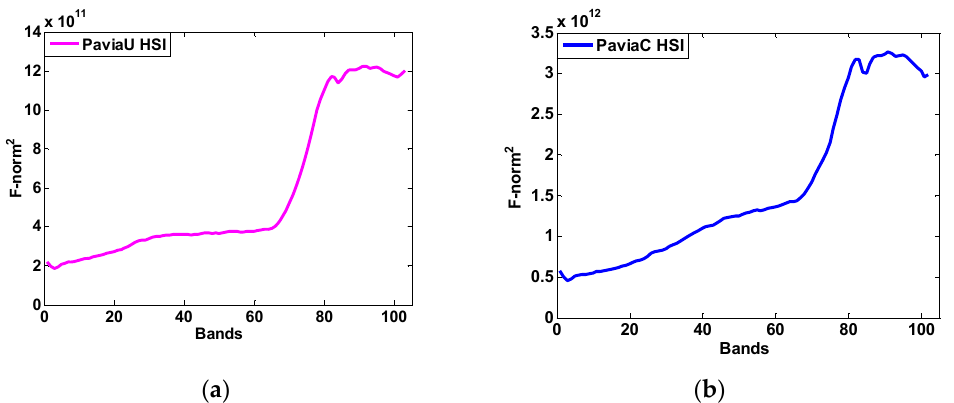
Figure 6. Square of the Frobenius norm (F-norm) of Pavia city HSIs. ( a ) PaviaU HSI. ( b ) PaviaC HSI.